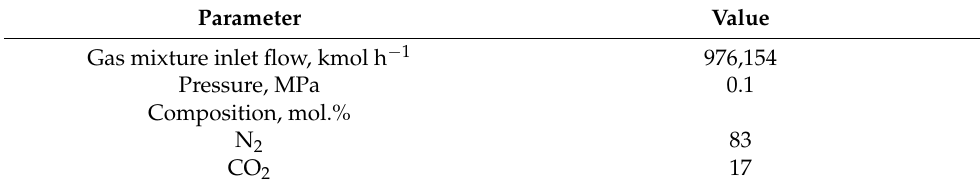
Figure 2. Principal scheme of the membrane column type of «Continuous Membrane Column». 1—membrane unit in the stripping section; 2, 3—membrane units in the enrichment section. Table 1. Input parameters of the separable gas